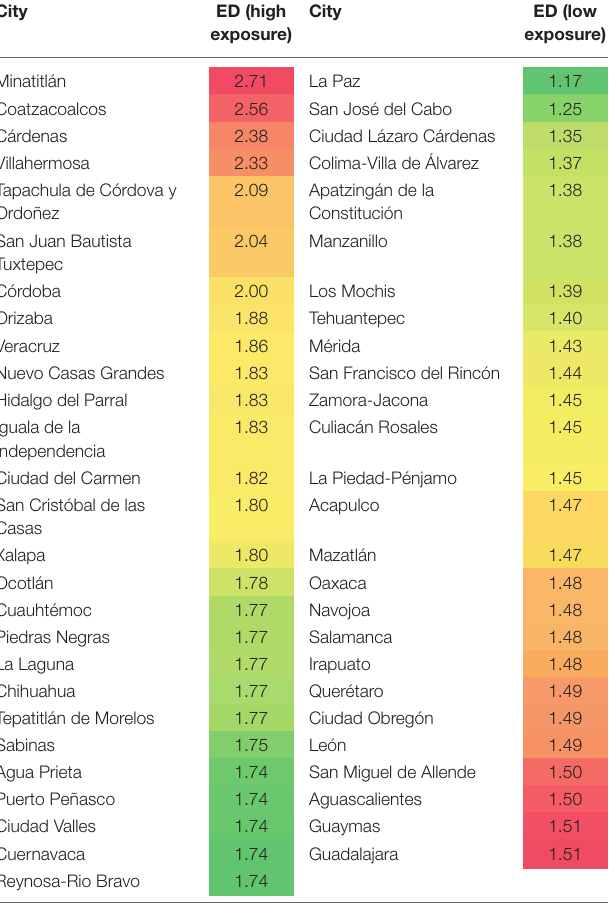
TABLE 4 | Ranking of Mexican cities according to its projected exposure to climate change in 2050. City